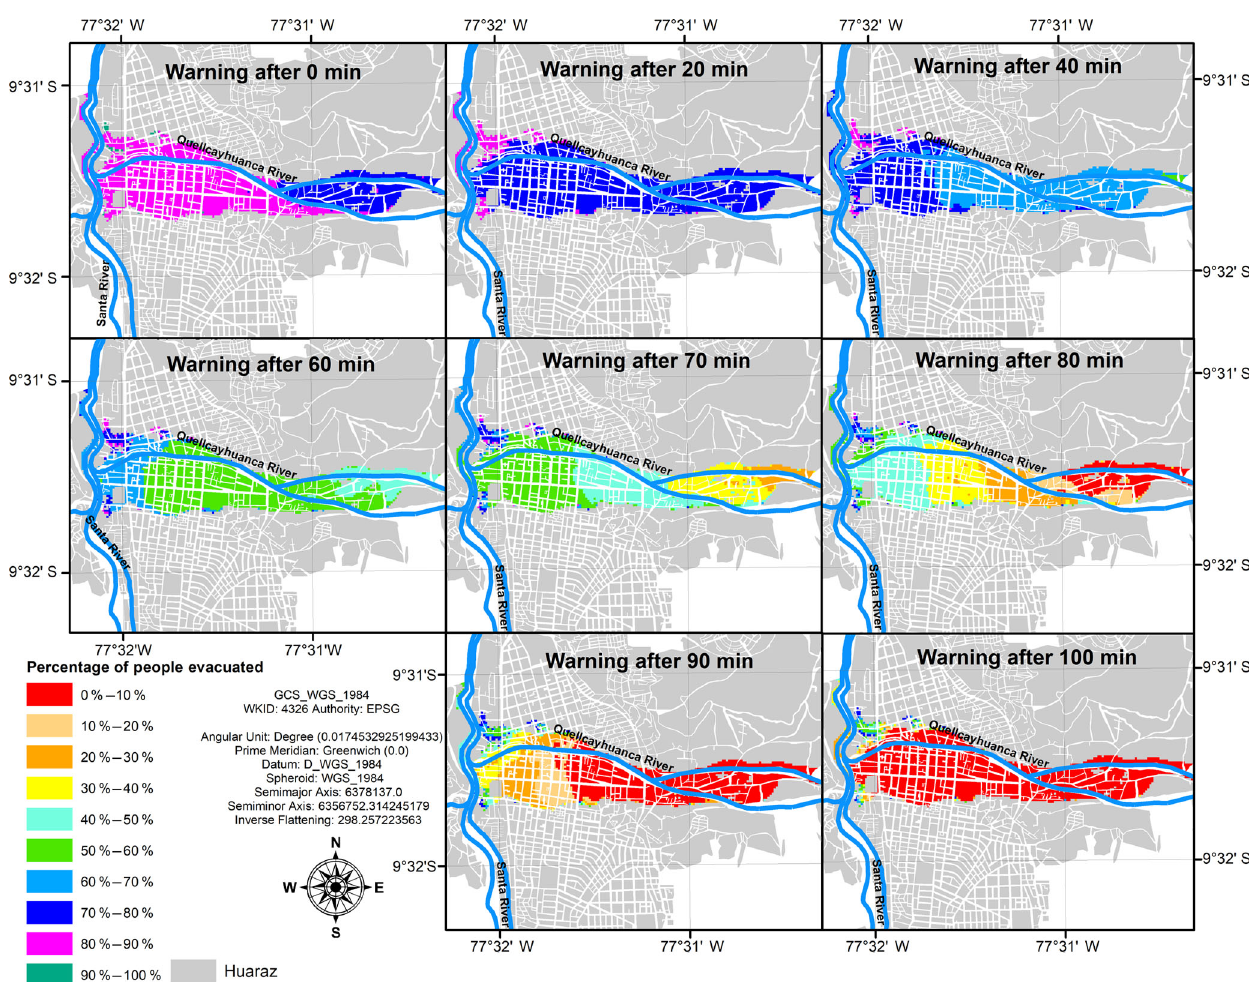
Figure 7. Evacuation using empirical